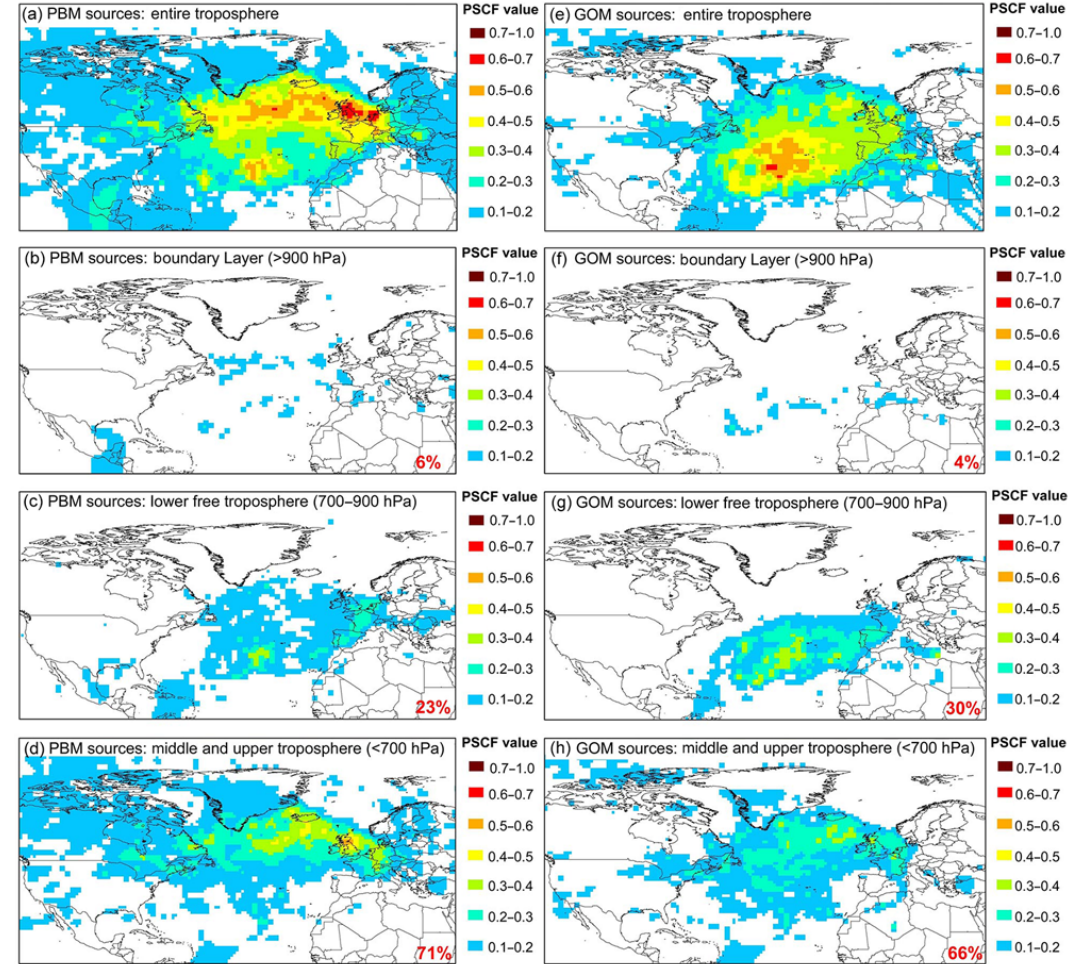
Figure 12. Map showing the identified potential source regions of PBM during the whole study period for (a) entire troposphere, (b) boundary layer, (c) lower free troposphere, and (d) middle and upper troposphere and potential source regions of GOM for (e) entire troposphere, (f) boundary layer, (g) lower free troposphere, and (g) middle and upper